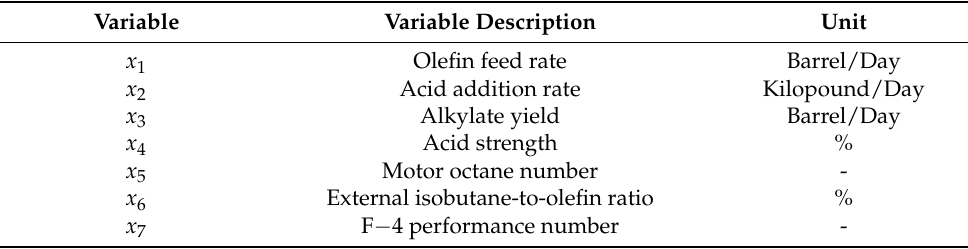
Table 6. The variables in the profit-maximization problem of the alkylation